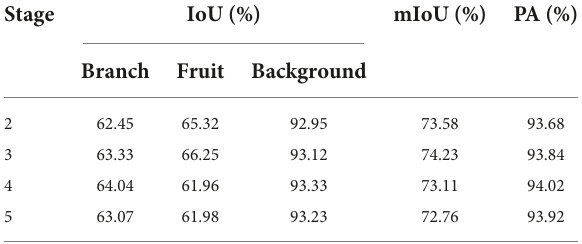
TABLE 2 Ablations on the auxiliary segmentation head, which is inserted after the output of different stages in the backbone.